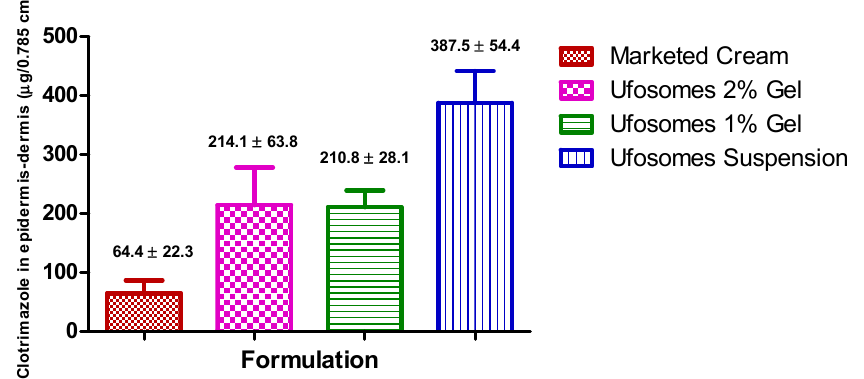
Figure 7. Amount of clotrimazole accumulated in epidermis-dermis layers of skin. Data are represented as mean ± SEM ( n = 3).